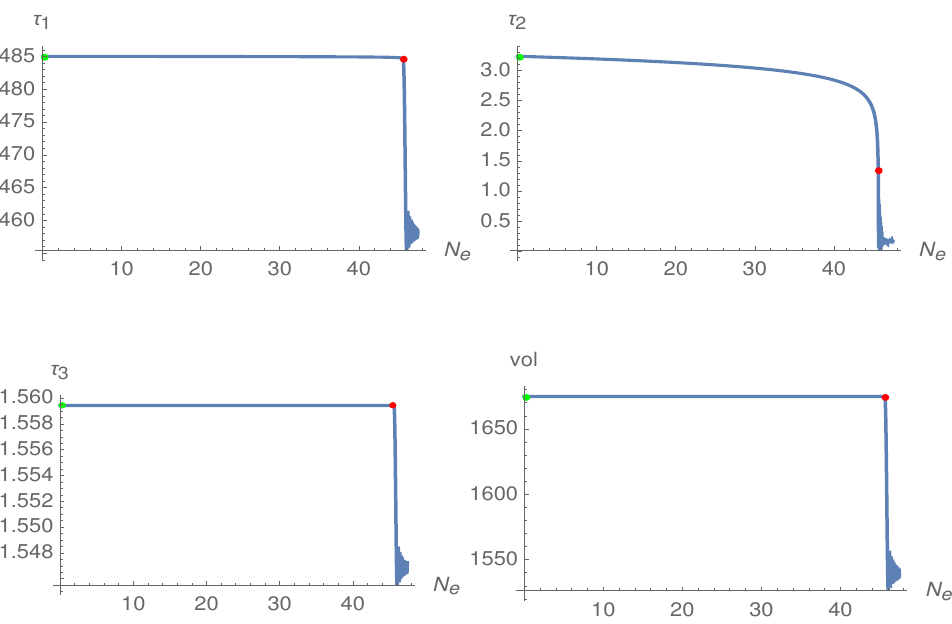
Figure 6 . In(cid:13)ationary evolution of all (cid:12)elds during the whole in(cid:13)ationary epoch for the third case in table 2 and 3. The green dot represents horizon exit while the red dot denotes the end of slow-roll in(cid:13)ation where (cid:15) s =